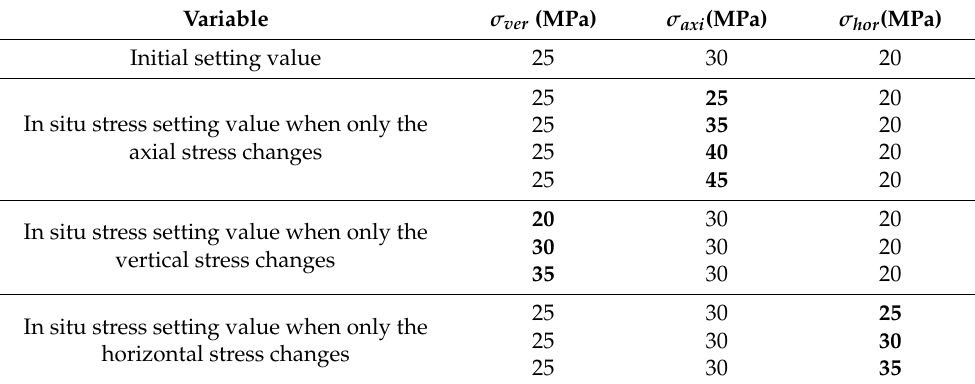
Table 1. Reference in situ stress setting